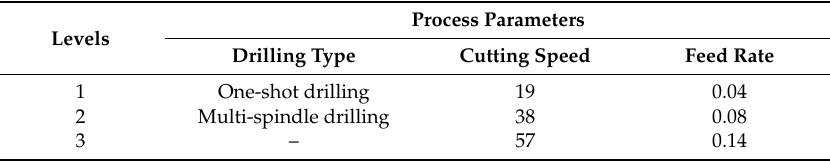
Table 2. Process parameters and their